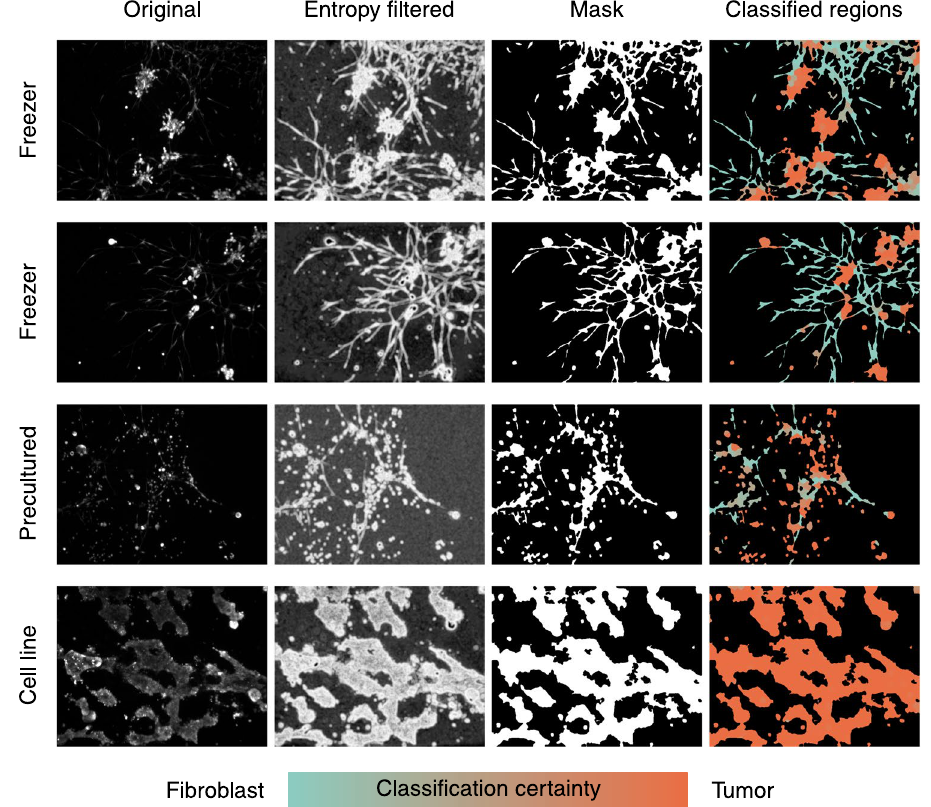
Figure 4. The suggested segmentation sequence and subsequent steps enable classification of different cell types in confocal images from PDX microtissue cultures. The original calcein-labeled live cell images, consisting of multicellular tumor organoids and fibroblasts were first local entropy filtered. Next, their foreground was separated from the background to obtain the segmentation masks. These masks were then split into individual regions that were subsequently classified into the two main cell types trained for. These were shown with distinct colors (Tumor cells: orange, CAFs/Fibroblast: blue). The color shading indicates the certainty of the classification. Cultures started directly from frozen cultures, from pre-cultured cells or by the use of cell lines, illustrate the impact of controlling the amount of fibroblasts included into 3D cultures. These example images were not part of the ground truth training